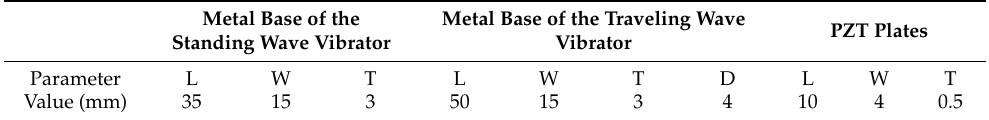
Table 2. Dimensions of the ultrasonic vibrators.